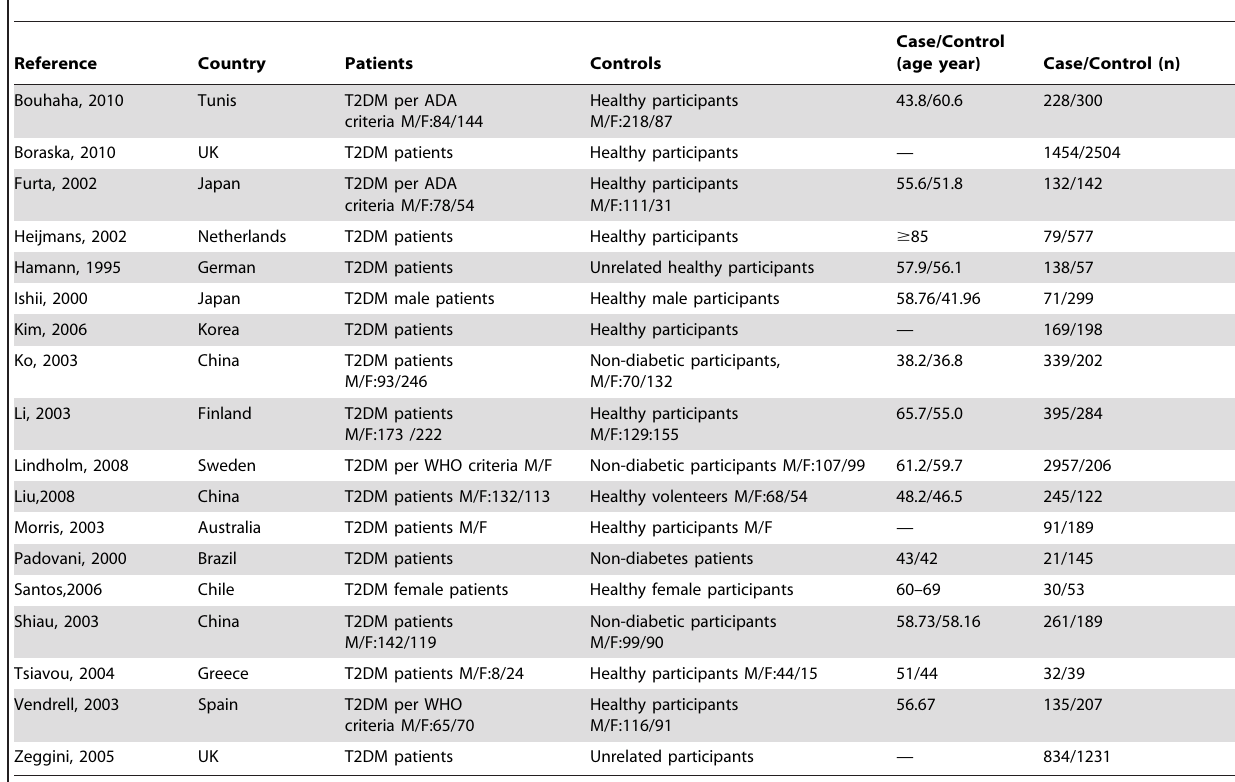
Table 1. Characteristics of publications included in meta-analysis of TNF 308 G/A polymorphism and T2DM.